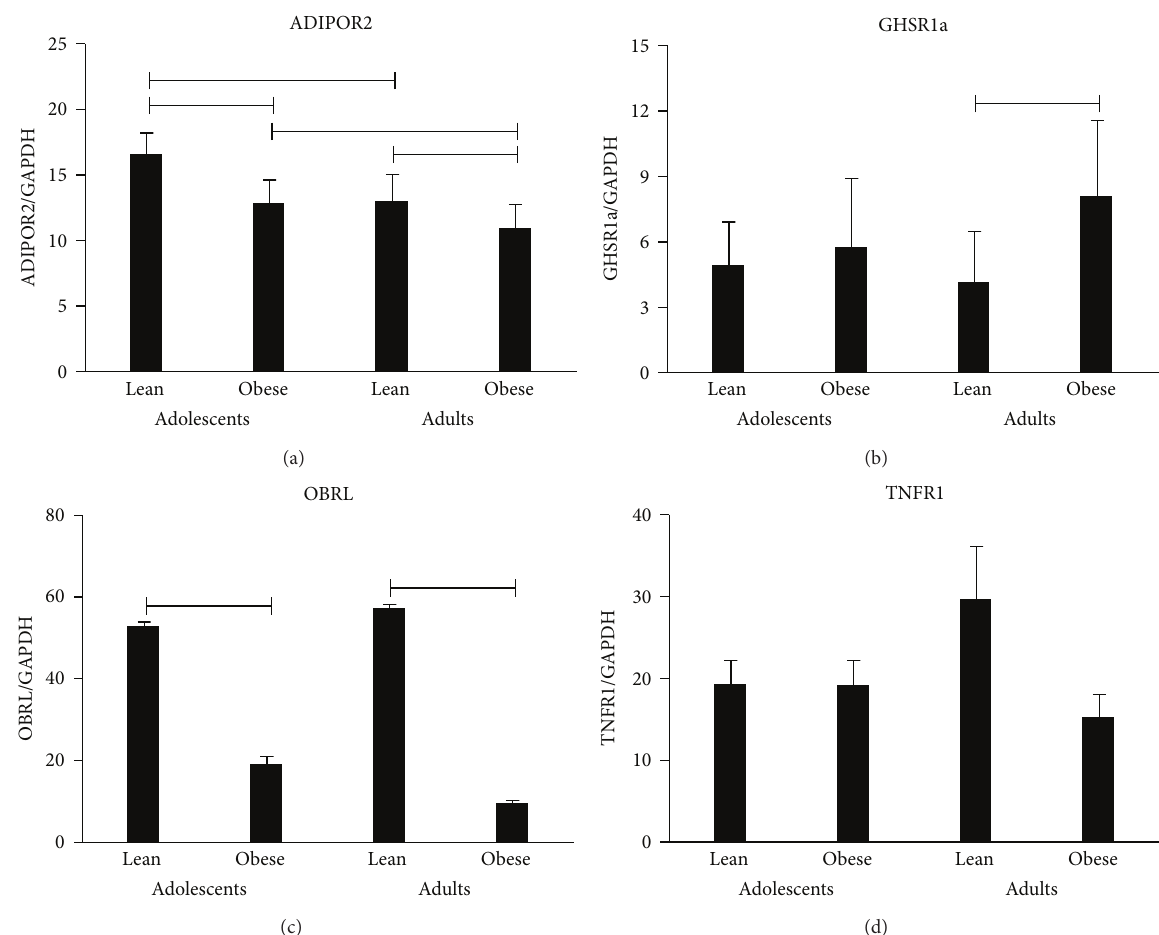
Figure 2: Leukocyte expressions of ADIPOR2, GHSR1a, OBRL, and TNFR1 in lean and obese adolescents and adults. Comparisons: 𝑃 < 0.05 .